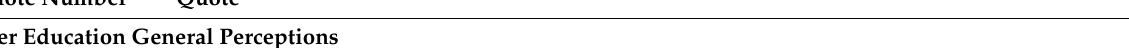
Table 2. Representative Subthemes and Supporting Quotes for Theme 2: Adolescents endorse a youth peer educator model for diabetes prevention, and describe ideal qualities for peer leaders, strategies for building relationships between program leaders and participants, and methods to motivate, support and evaluate